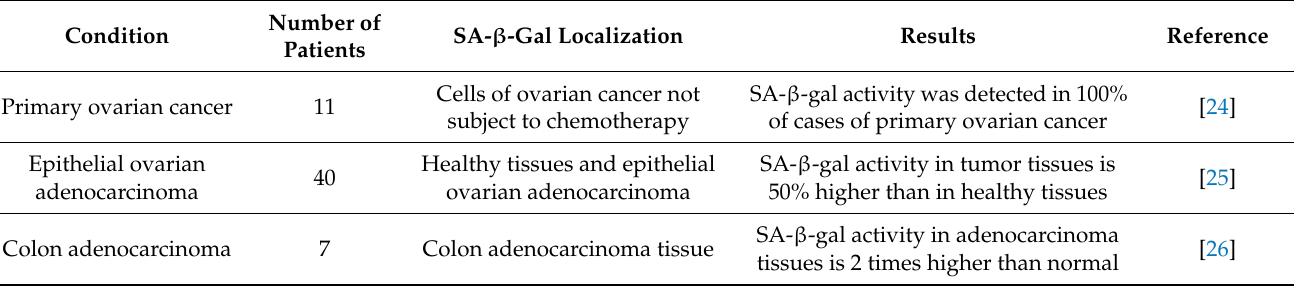
Table 1. Research studies with results of SA- β -gal analysis in patient